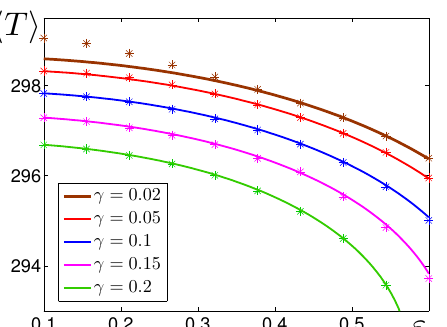
Figure 9. Mean values of T -coordinates of system (1), (2) solutions with σ 1 = 1, σ 2 = 0 versus ε . Results of analytical estimations are plotted by solid lines, and results of direct numerical simulations are shown by asterisks.